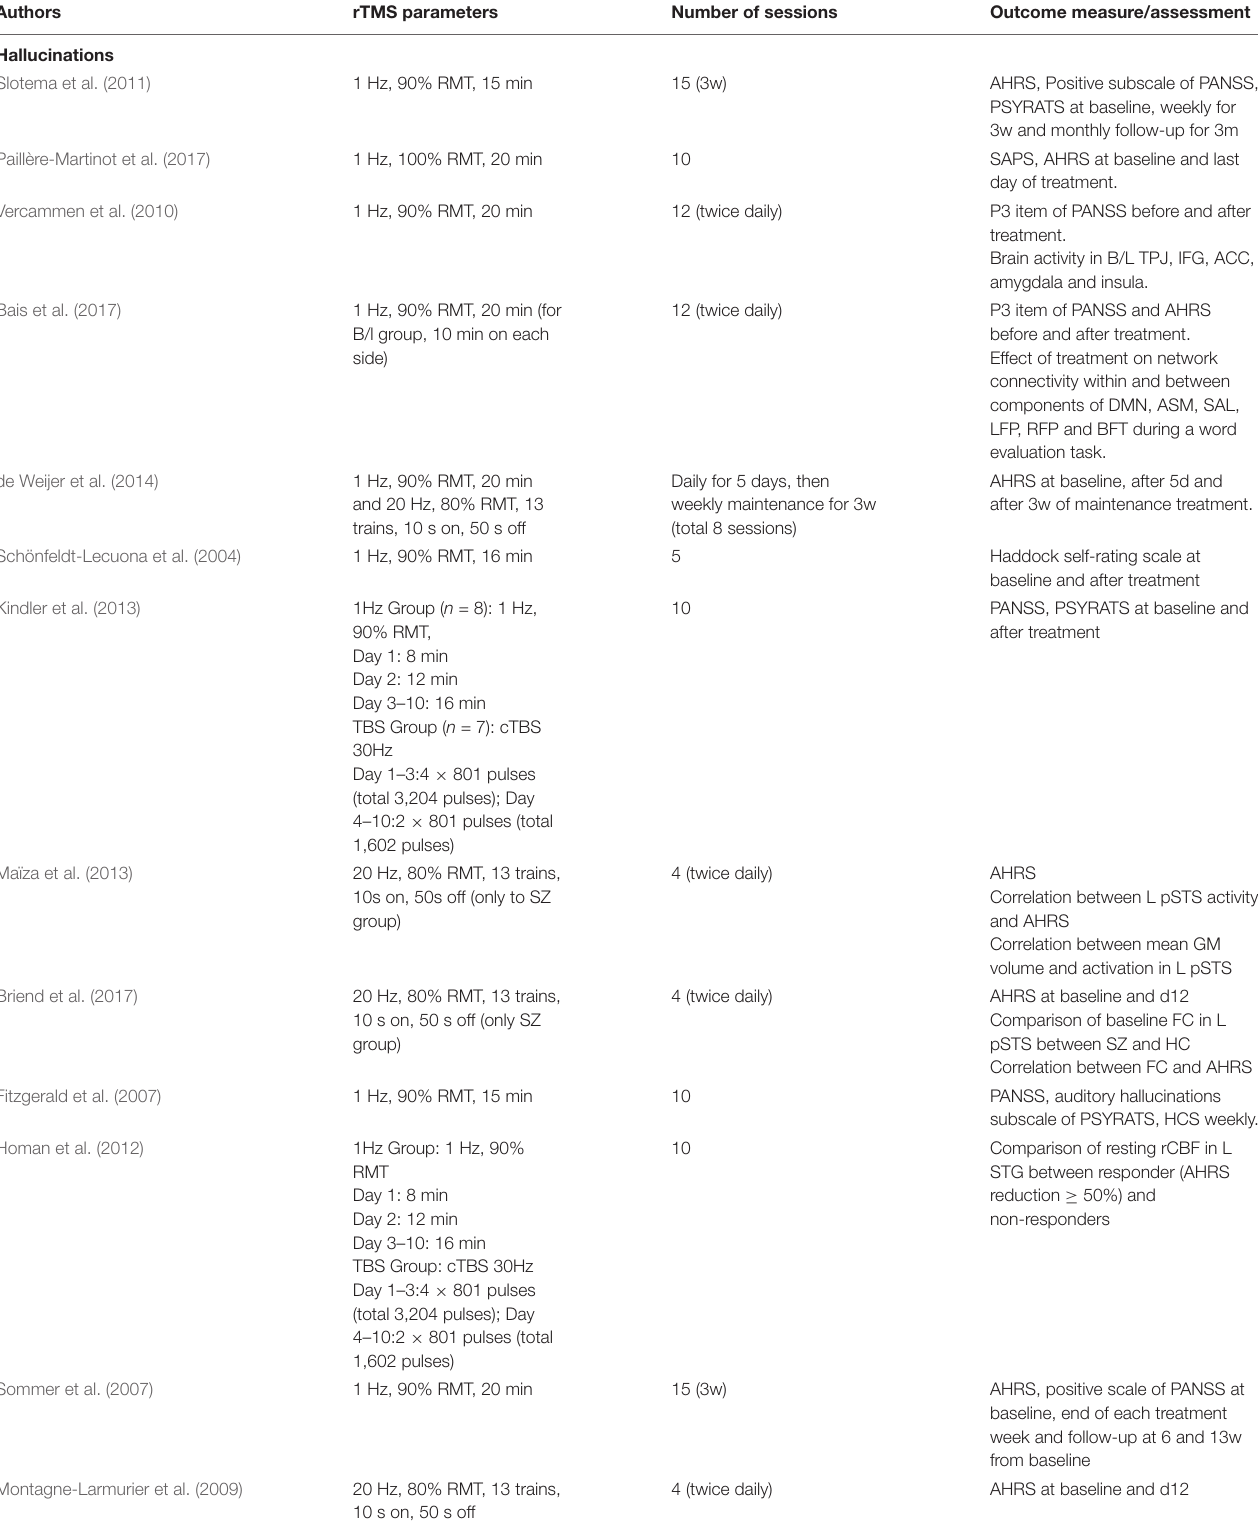
TABLE 2 | TMS/fMRI studies on treatment of schizophrenia: rTMS parameters and outcome